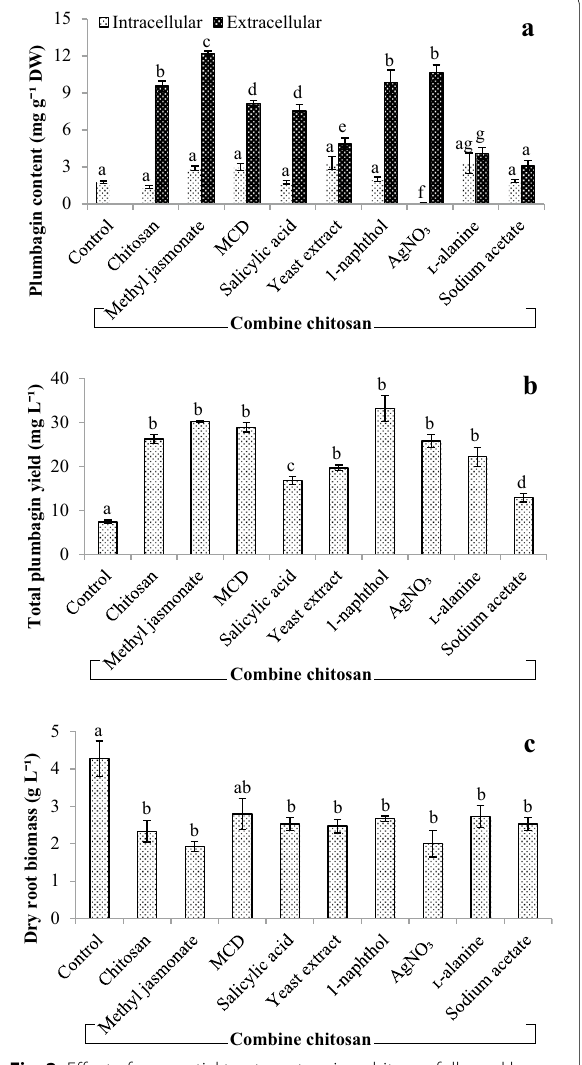
Fig. 2 Effect of sequential treatments using chitosan followed by other elicitors on a plumbagin content; b total plumbagin yield; c dry root biomass. Twelve-day P. indica root cultures were treated with 150 mg L − 1 chitosan followed by 14-day treatments with methyl jasmonate, salicylic acid, 1-naphthol, yeast extract, MCD, AgNO 3 , sodium acetate and ʟ -alanine. Control is untreated root cultures with equal amount of distilled water or 2% ethanol added. Chitosan is the singly treated at 14 days. Measurements were taken after 72-h treatment from day 14 treatments. Values are mean of triplicate experiments. Data were analyzed by one-way ANOVA, using Tukey’s test for multiple comparison. Different superscripts letters between the groups are significantly different at p < 0.05. MCD; methyl-β-cyclodextrin